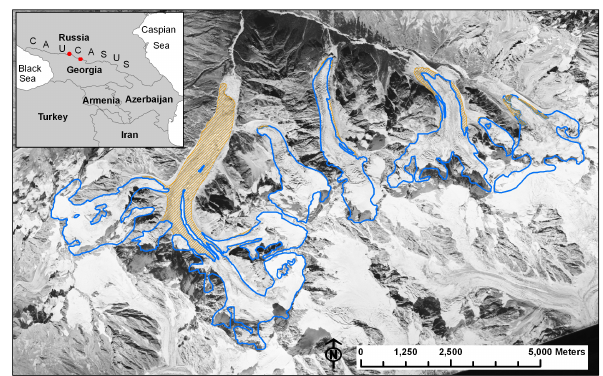
Fig. 1. CORONA image of the Adyl-su Valley from Septem- ber 1971 with the boundaries of the selected glaciers (the Djankuat Glacier is at the far right) and the supra-glacial debris cover extent